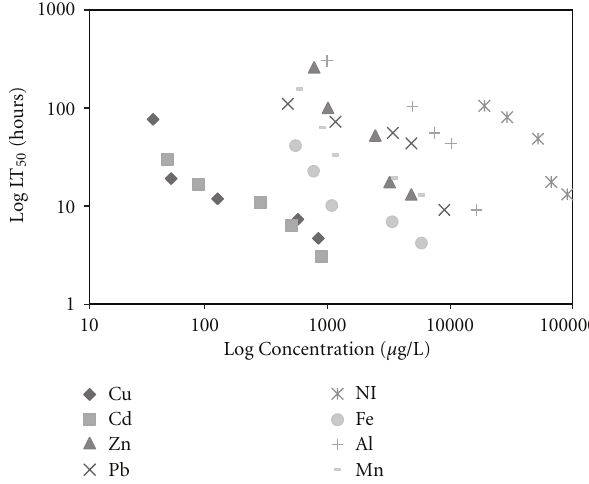
Figure 2: The relationship between median lethal time (LT 50 ) and exposure concentrations for S. major